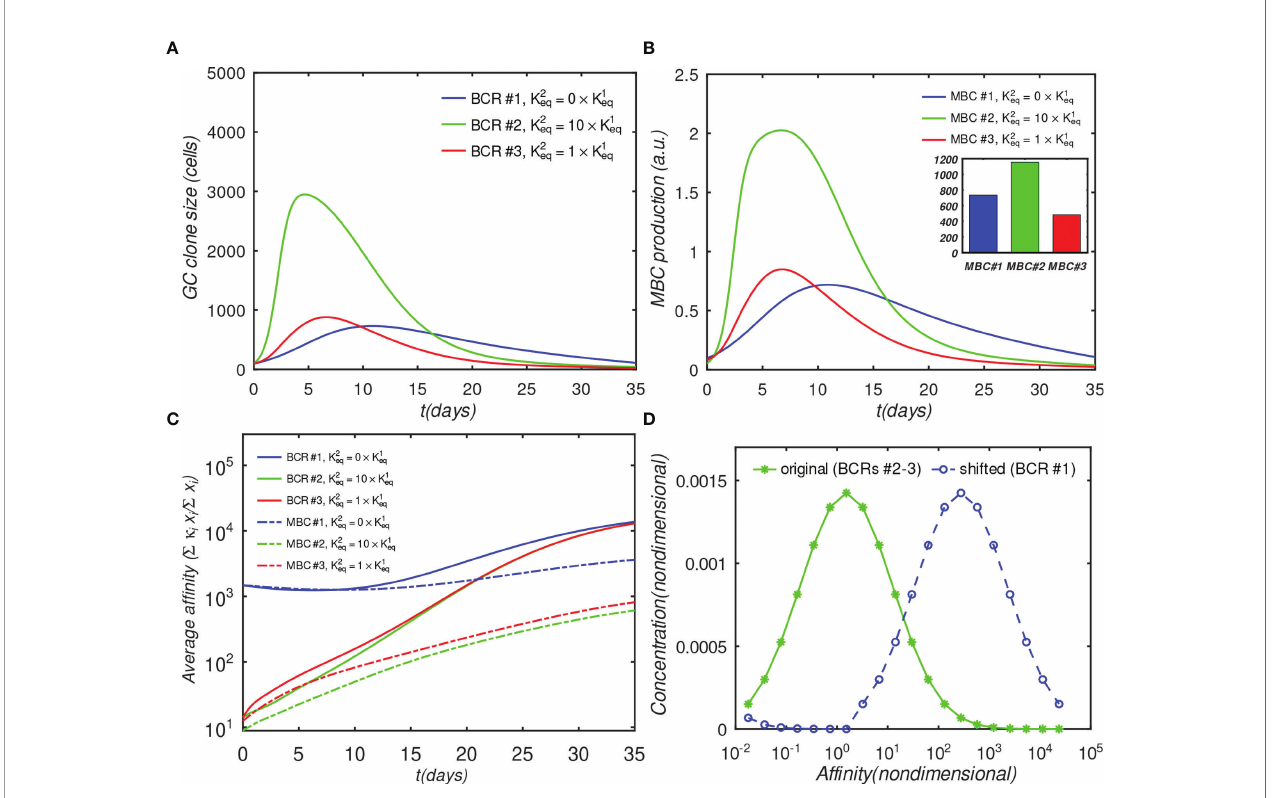
FIGURE 5 | Effect of initial af fi nity advantage on the growth of monovalent B-cells in the fully interacting B-cell case ( o = 1). Panels (A – C) show the same quantities as Figures 4A – C ; The af fi nity distribution corresponding to BCR#1 was shifted toward higher values relative to BCR#2 and BCR#3 panel (D)